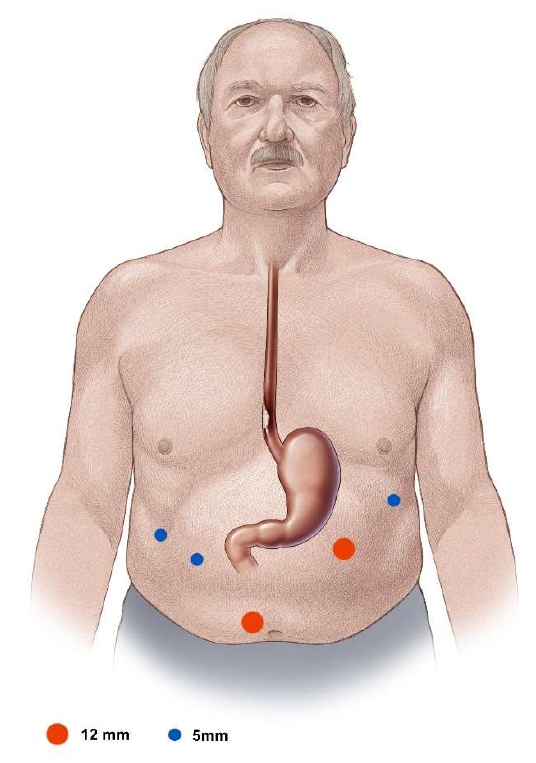
Figure 2. Trocar placement.